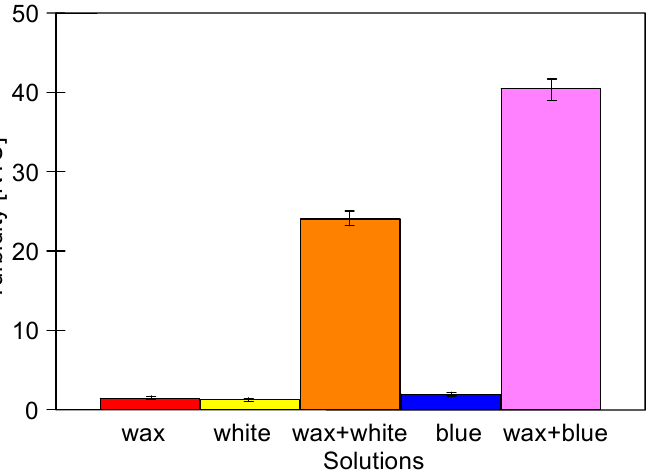
Figure 2. Turbidity of cleaning agents solutions. Concentrates: 0.2% (wax), 0.5% (white), and 0.5% (blue).